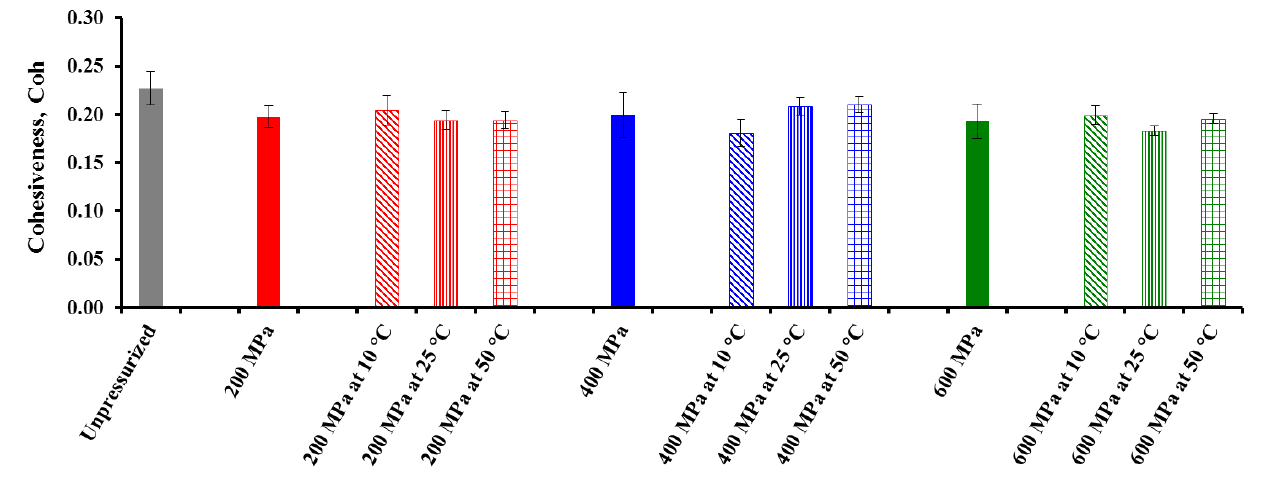
Figure 6. Effect of pressure and treatment temperature on the cohesiveness ( Coh ) of chickpea gel heat-induced from pressurized powder at 25 °C. Mean values of 10